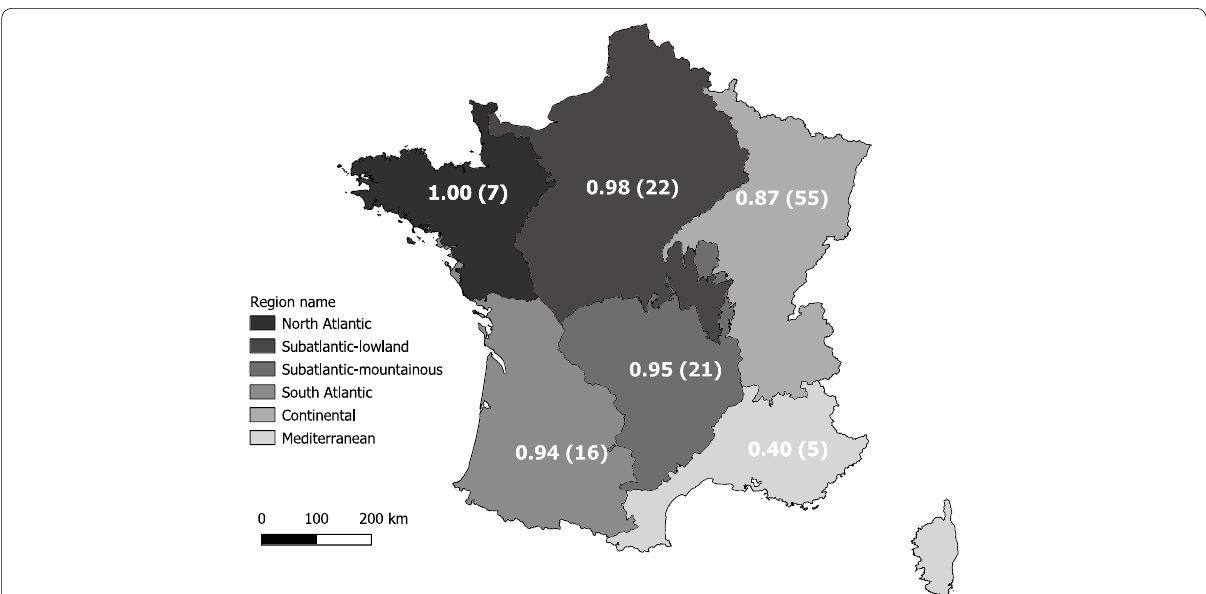
Fig. 2 Overall frequency of vegetation control according to the survey of forest managers performed in six regions in France. For each region, the average frequency of intervention for vegetation control (0, rarely or never; 0.5, sometimes; 1, frequently or very frequently) and the number of respondents (in brackets) are indicated. The shades of gray indicate the average frequency of vegetation control in each study